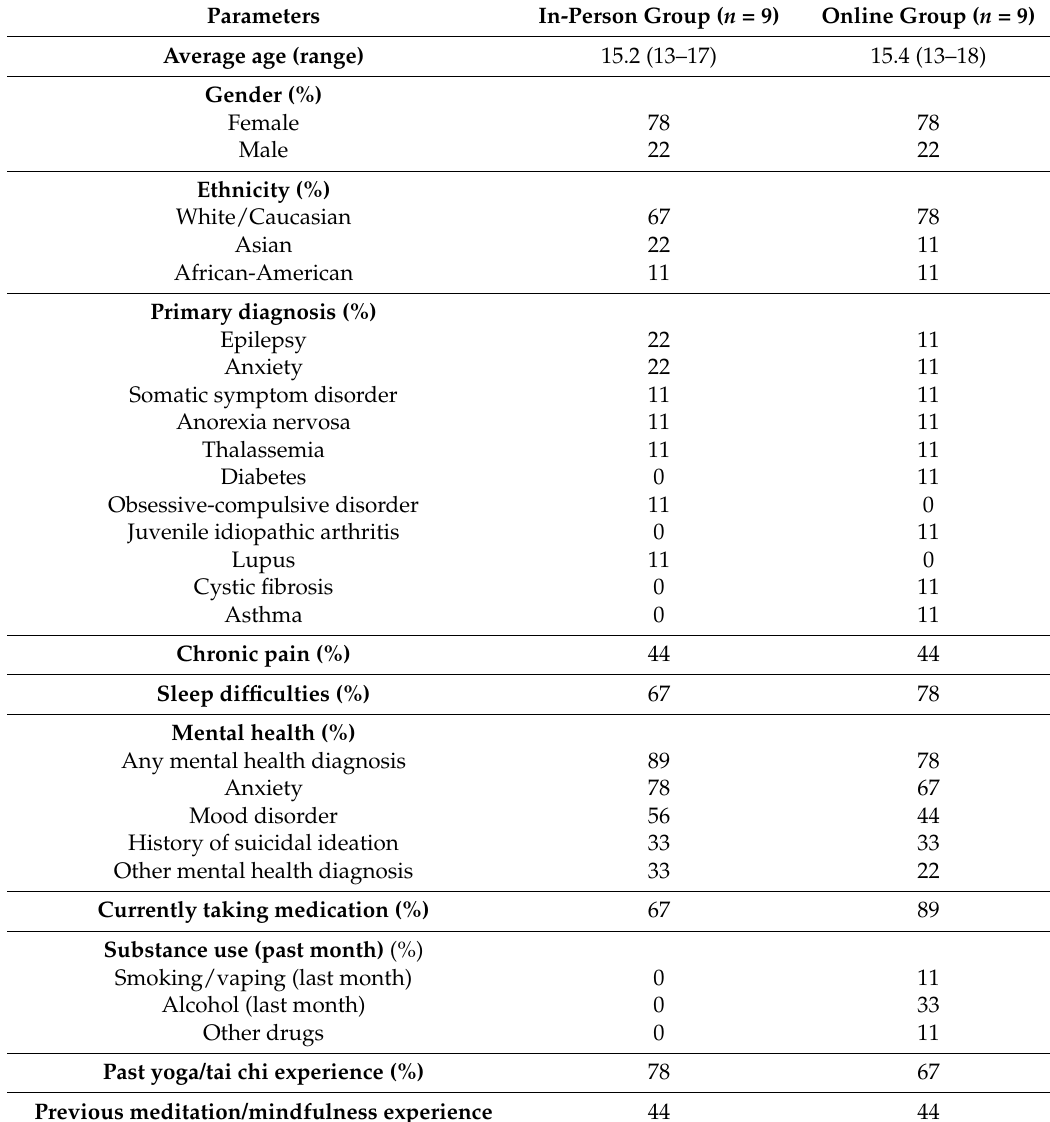
Table 1. Participant characteristics at